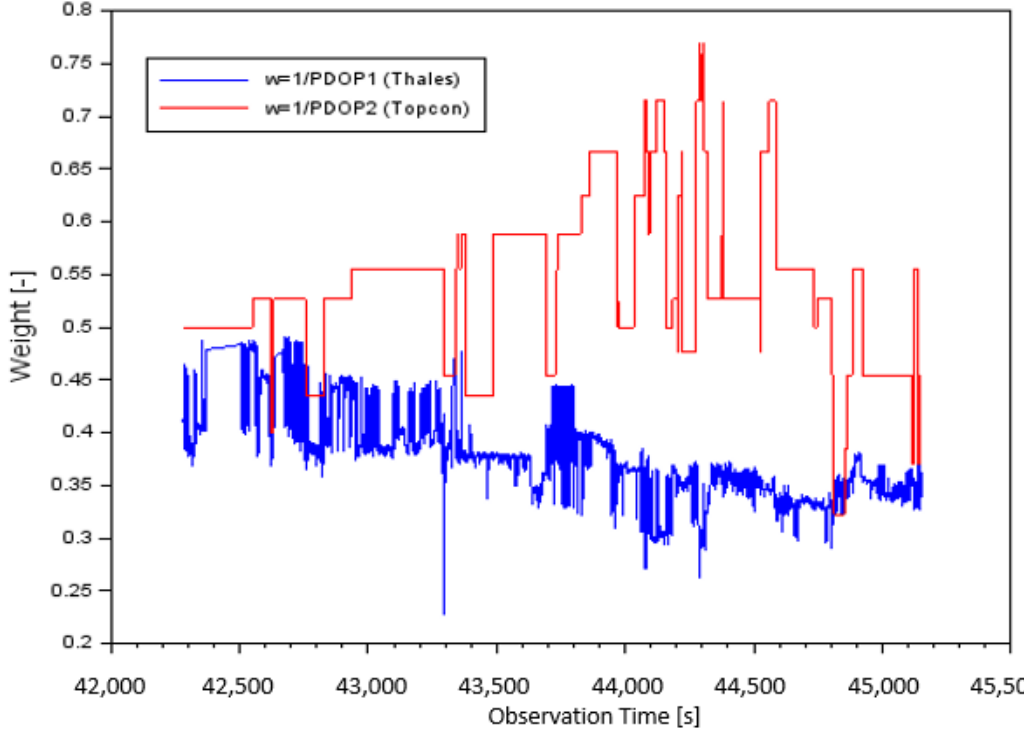
Figure 3. The weight value for Case II: Thales (blue) and Topcon (red).